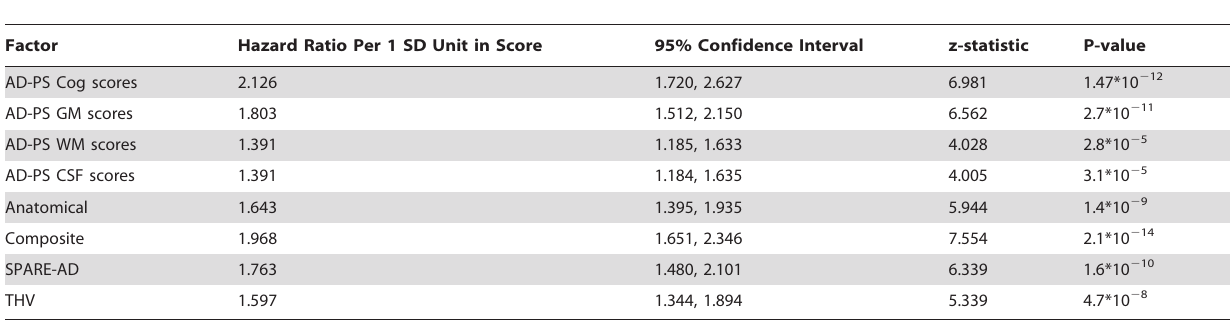
Table 5. Results from proportional hazards regression to assess associations with the distribution of times until conversion to